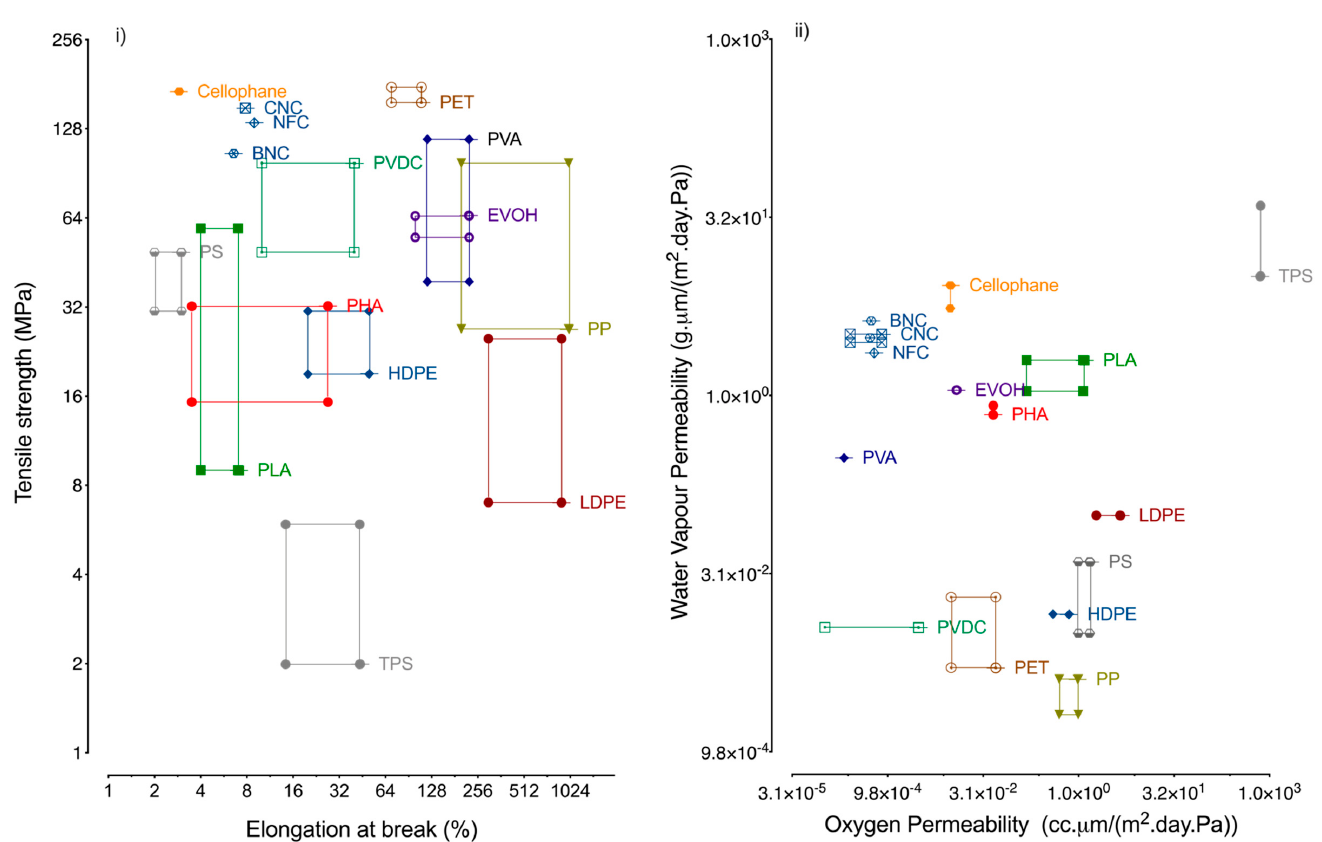
Figure 1. Properties of synthetic and bio-based polymers: ( i ) Tensile strength (MPa) vs elongation at break (%); ( ii ) Water vapour permeability vs Oxygen permeability; the values, obtained at 23–25 °C and normalized in terms of relative humidity (50% RH), were calculated from [2,19,29–43]. PET-Polyethylene Terephthalate; PP-Polypropylene; LDPE-Low density polyethylene; HDPE- High density polyethylene; PS-Polystyrene; PVDC-Polyvinylidene chloride; PVA-Poly vinyl alcohol; EVOH-Ethylene vinyl alcohol; PLA-Poly lactic acid; PHA-Polyhydroxyalkanoates TPS-Thermoplastic starch.